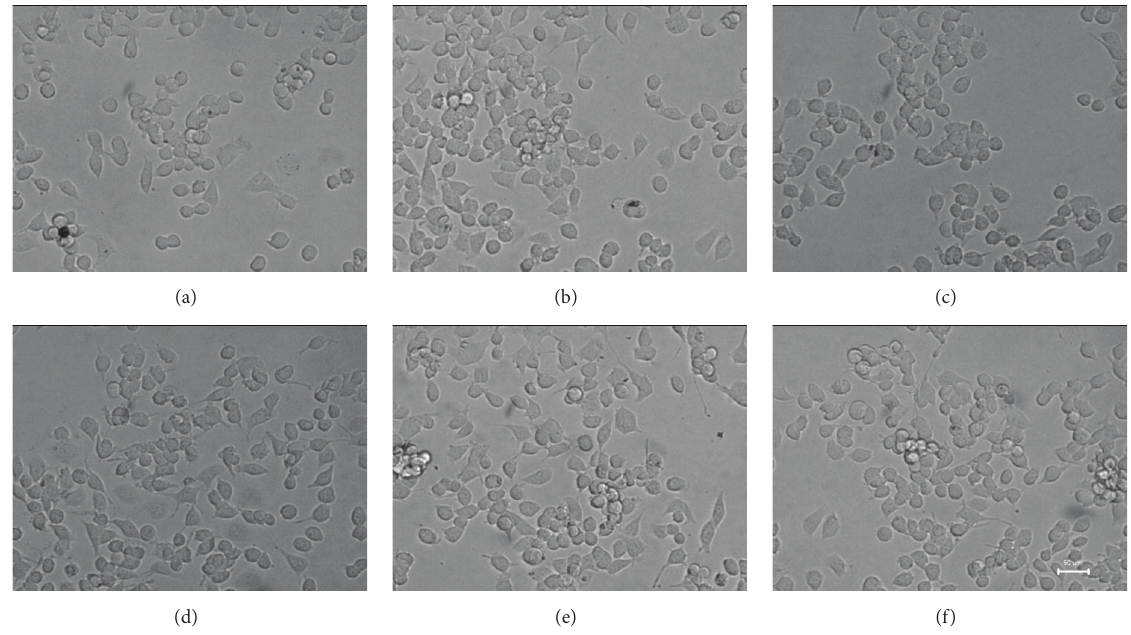
Figure 2: The morphology of BV-2 cells exposed to MPP + at various time points (20x). (a) 0 h; (b) 1h; (c) 3 h; (d) 6h; (e) 12h; (f) 24h. Note that the activation status of BV-2 cells was most evident after incubation with 0.1mM MPP + for 12 hours.